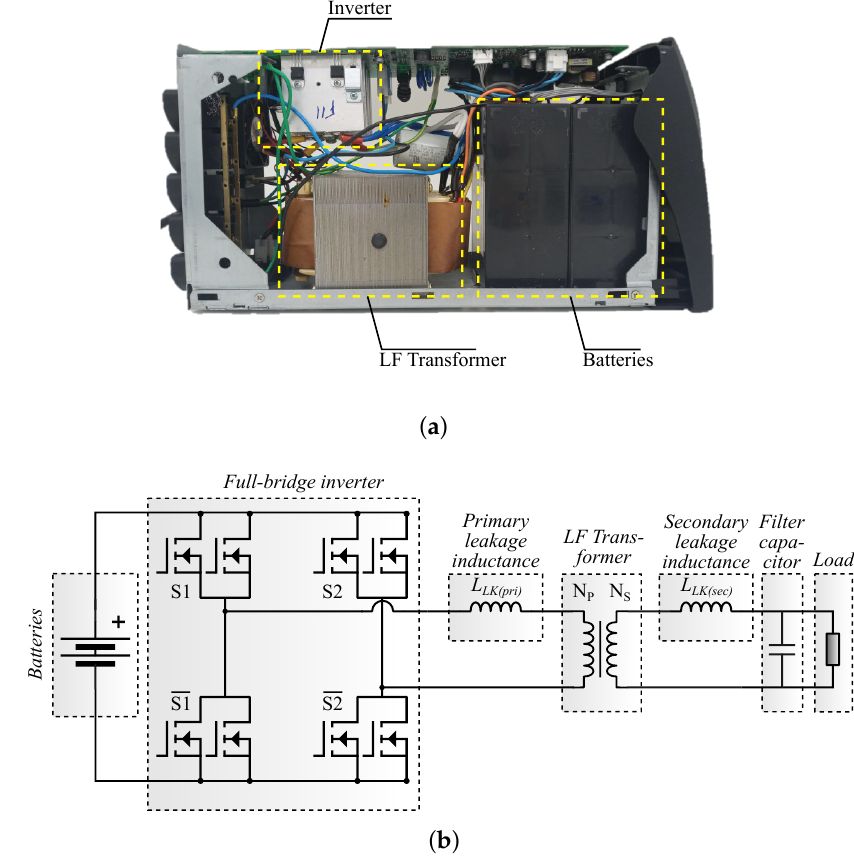
Figure 2. ( a ) Commercial line-interactive ferroresonant-based UPS of 1 kW. ( b ) Offline or line- interactive ferroresonant-based UPS equivalent circuit of operation in backup mode